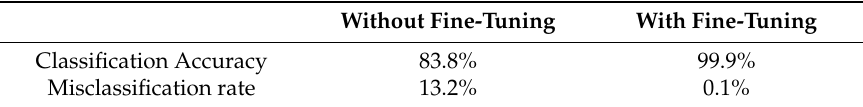
Figure 12. Performance comparison of fine-tuning with ROC curves: ( a ) Results without fine-tuning; ( b ) Results with the fine-tuning approach. Table 11. Classification performance with and without a fine-tuning strategy.